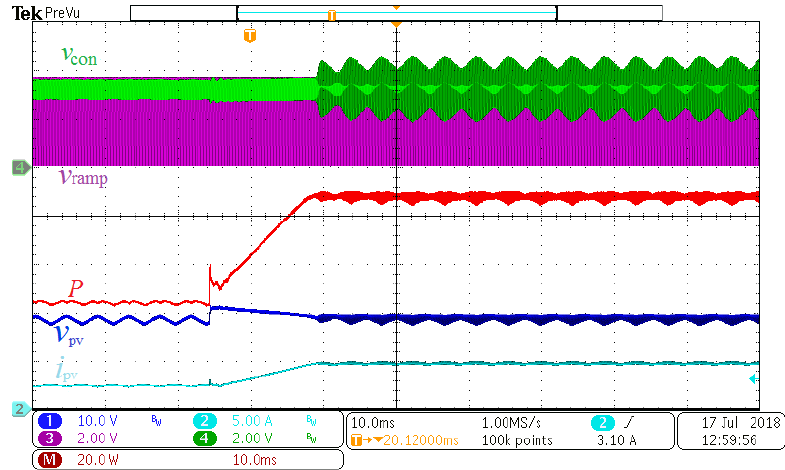
Figure 14. The experimental PV system response due to a change of step type in the irradiance level from 500 W/m 2 –1000 W/m 2 as in Figure 9. V M = 4